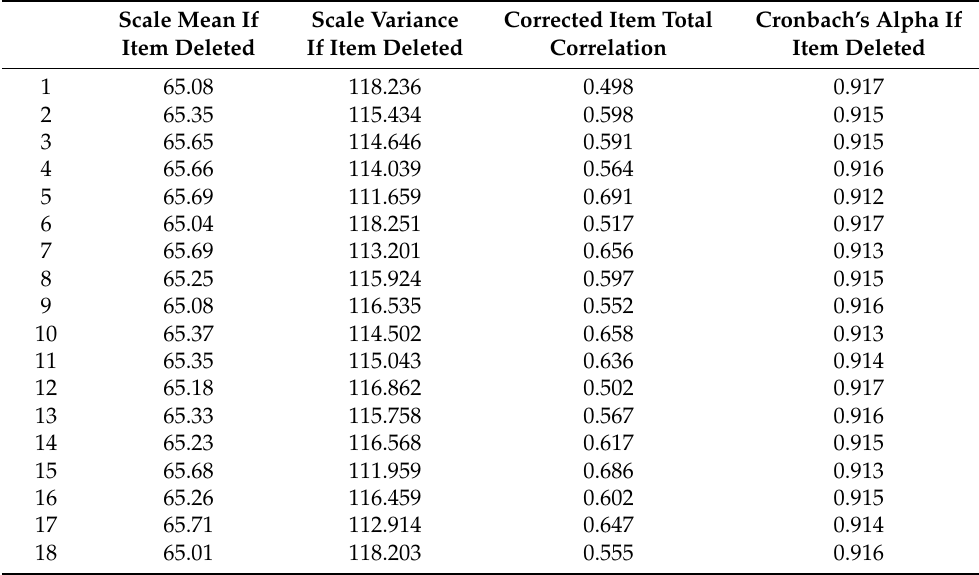
Table 3. The overall statistics of each item of the Physical Activity Triggers Questionnaire.